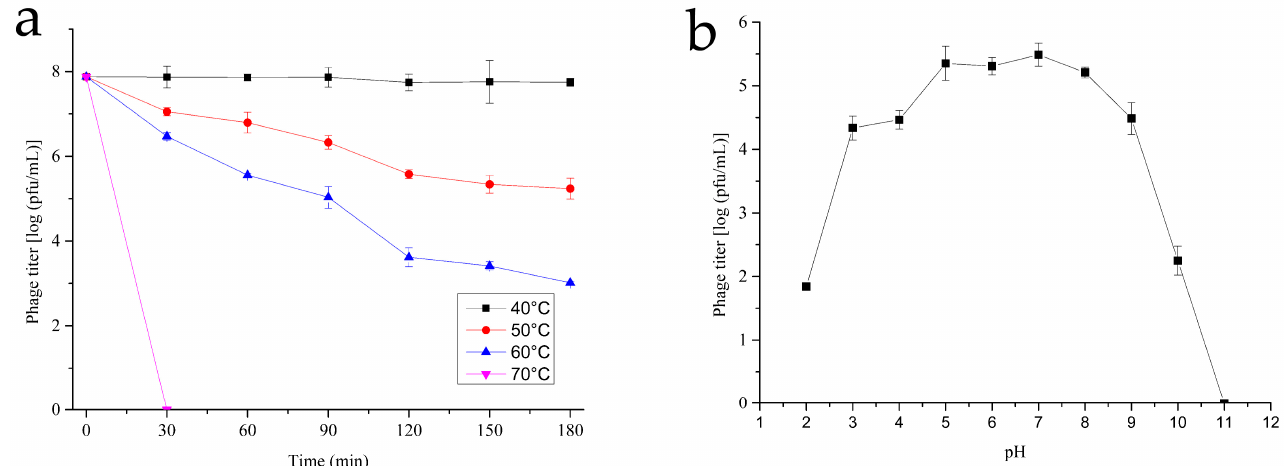
Figure 3. Thermostability ( a ) and pH stability ( b ) of Vibrio phage Yong-XC31. All the experiments were conducted in triplicates.